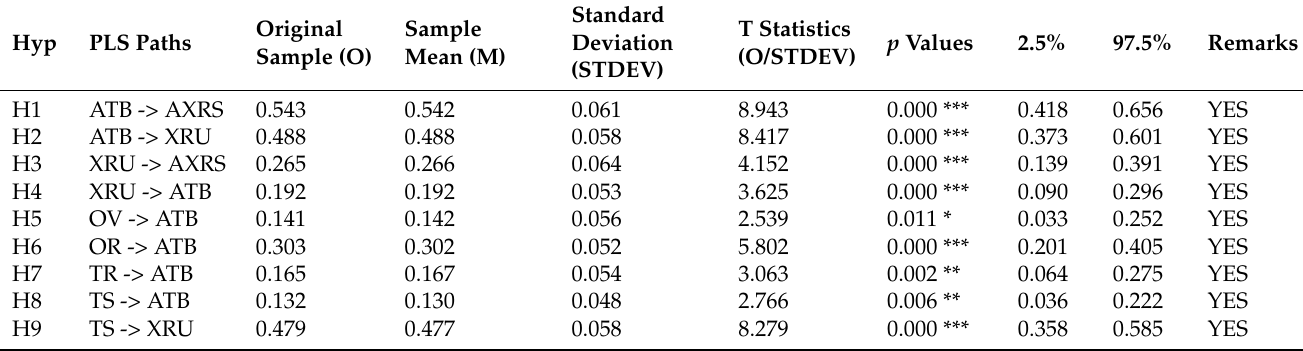
Table 6. Hypothetical structure model.